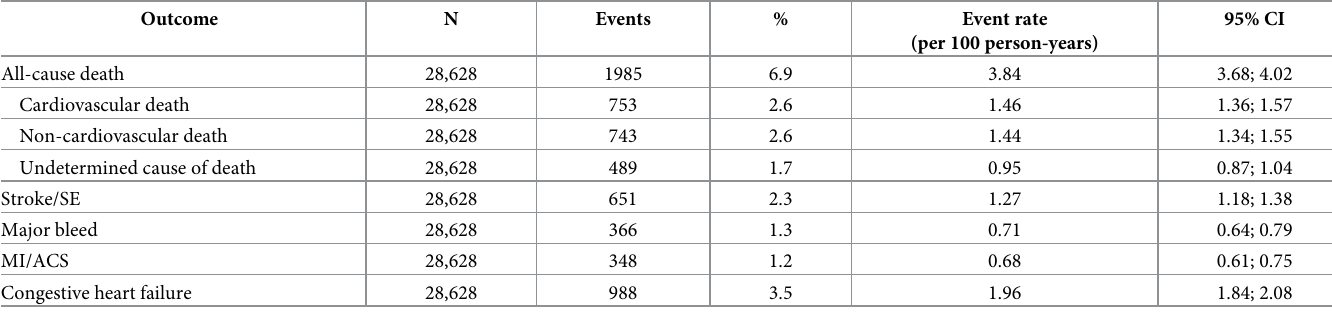
Table 4. Two-year event rates including additional outcomes.